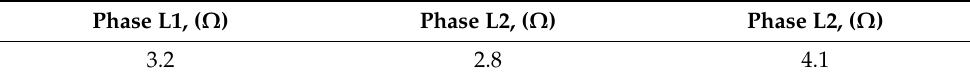
Table 1. One-phase short-circuit impedance estimation for Object